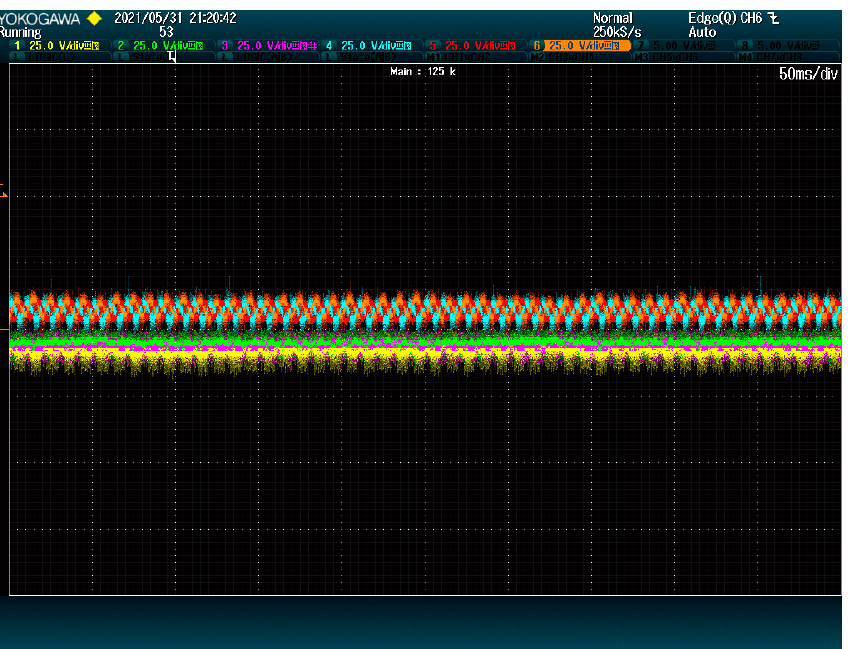
Figure 11. Modules DC-Link voltage when reducing ripple. The plot shows voltage (25 V/div) vs. time (50 ms/div).